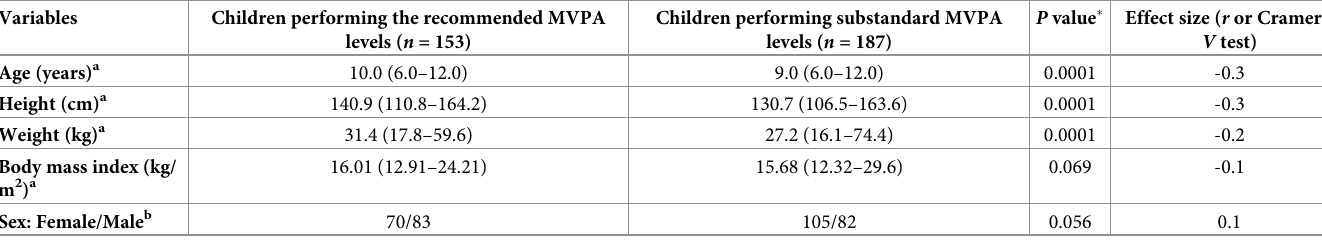
Table 1. Demographic characteristics of study participants.